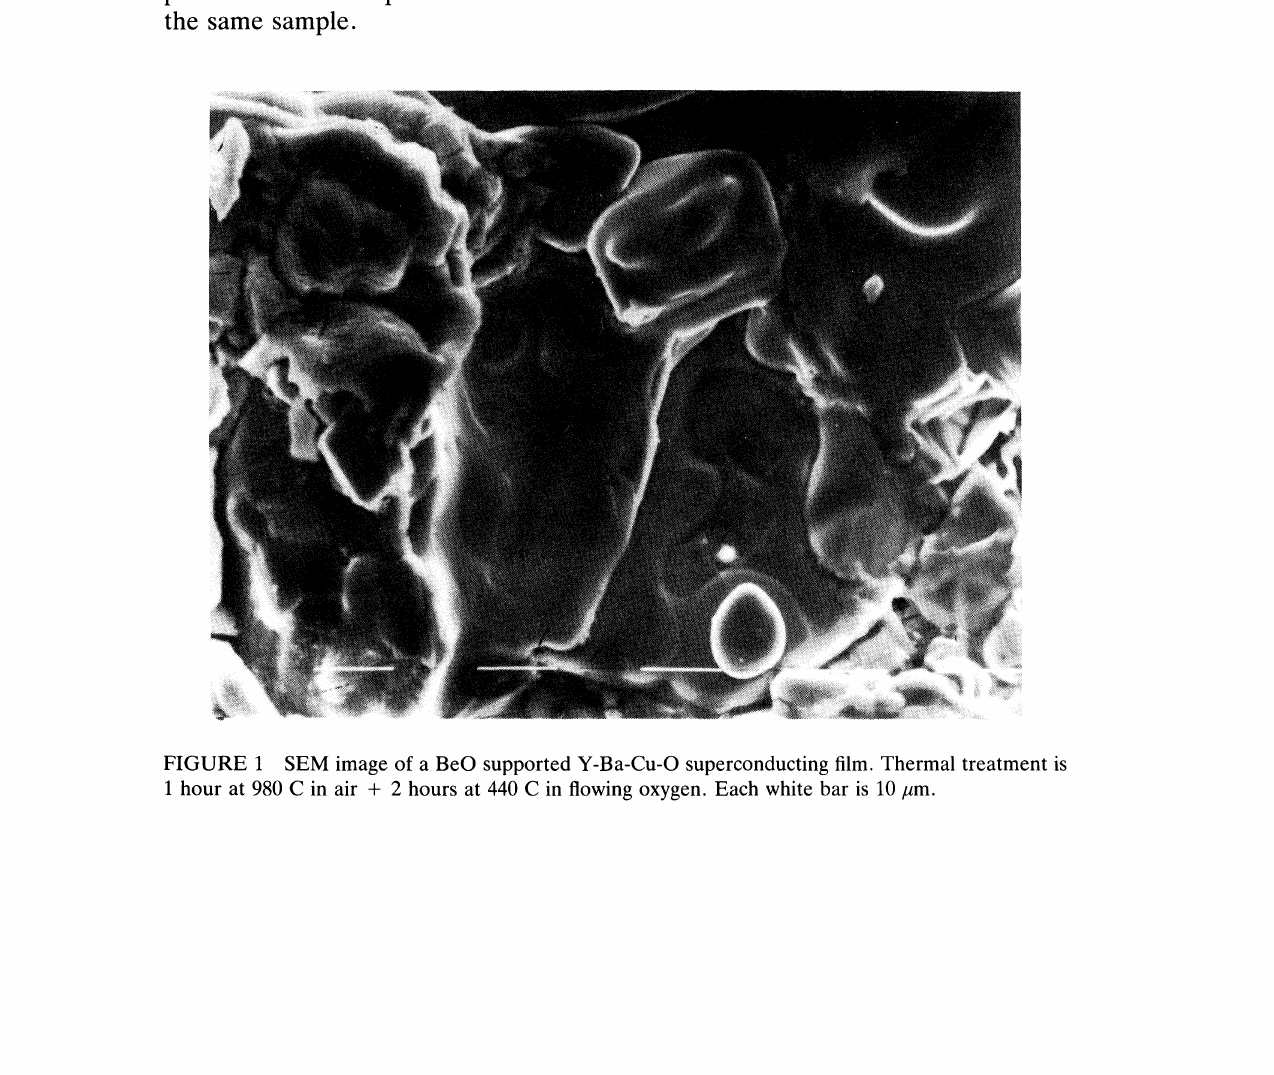
FIGURE SEM image of a BeO supported Y-Ba-Cu-O superconducting film. Thermal treatment is hour at 980 C in air + 2 hours at 440 C in flowing oxygen. Each white bar is